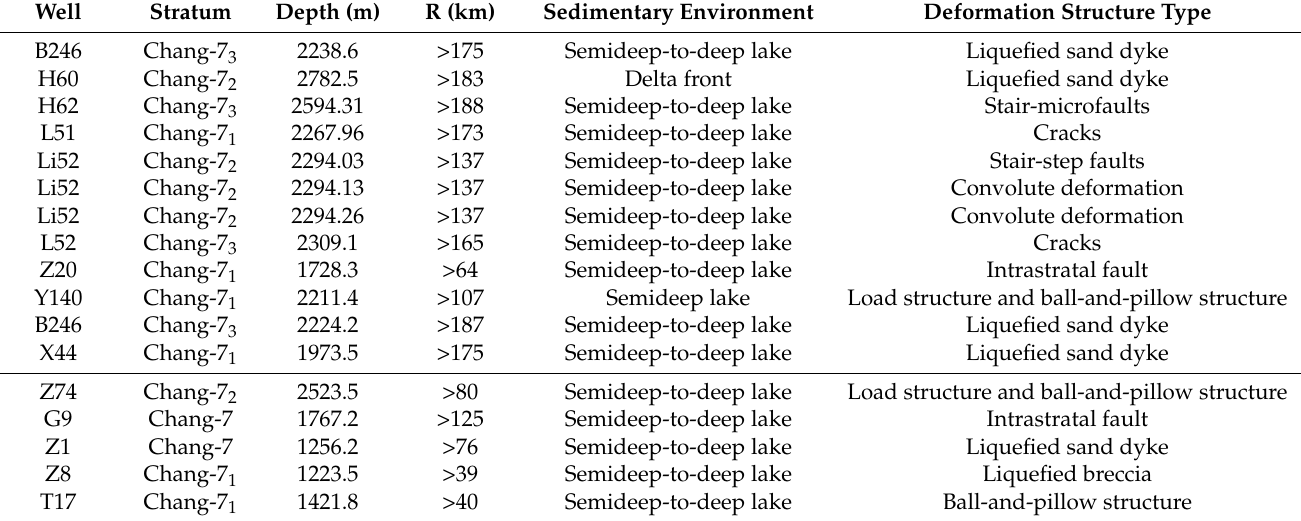
Table 2. Development location and type of seismicity-induced SSDSs in the Chang-7 Member